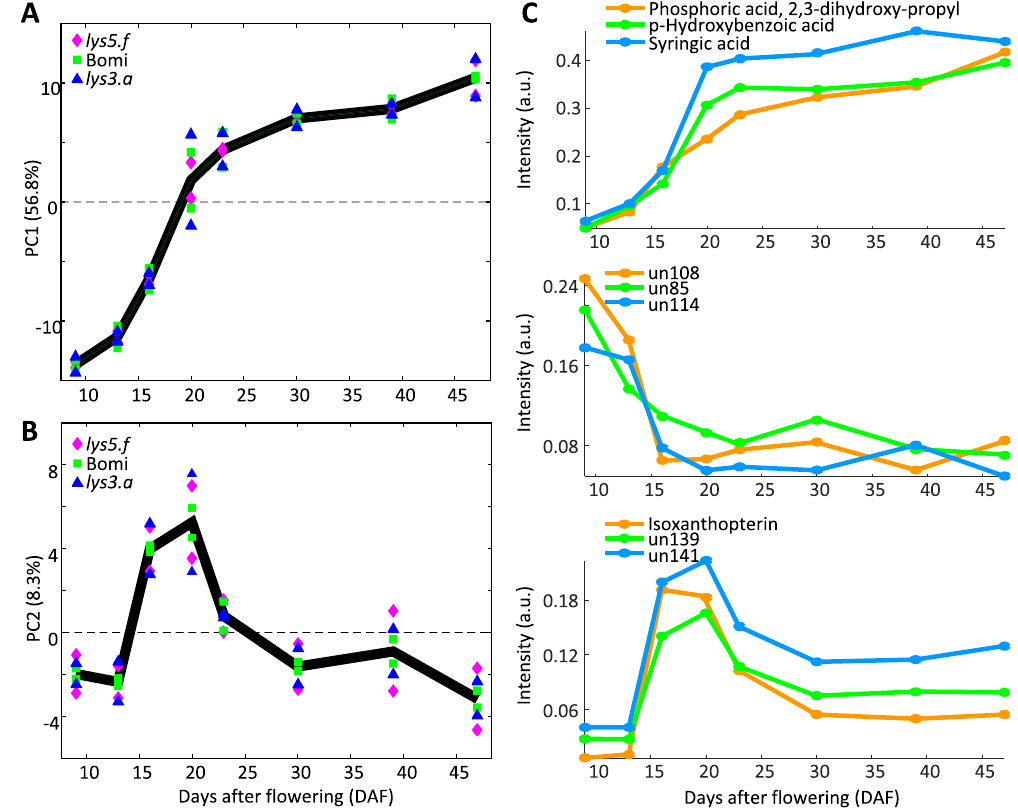
Figure 4. Development of the barley seed metabolome during grain filling. Principal component analysis (PCA) of the ANOVA-simultaneous component analysis (ASCA)-based days after flowering (DAF) effect separated matrix, X DAF , revealed three main trends over which relative concentrations of metabolites changed during grain filling. ( A ) Principal component (PC)1 explained more than half of the total variation and revealed two trends, accumulation and depletion. ( B ) PC2 of the same model explained 8% variation and revealed an accumulation followed by depletion trend. ( C ) Relative mean concentrations, calculated from the raw data, showing some metabolite examples that follow one of the three developmental